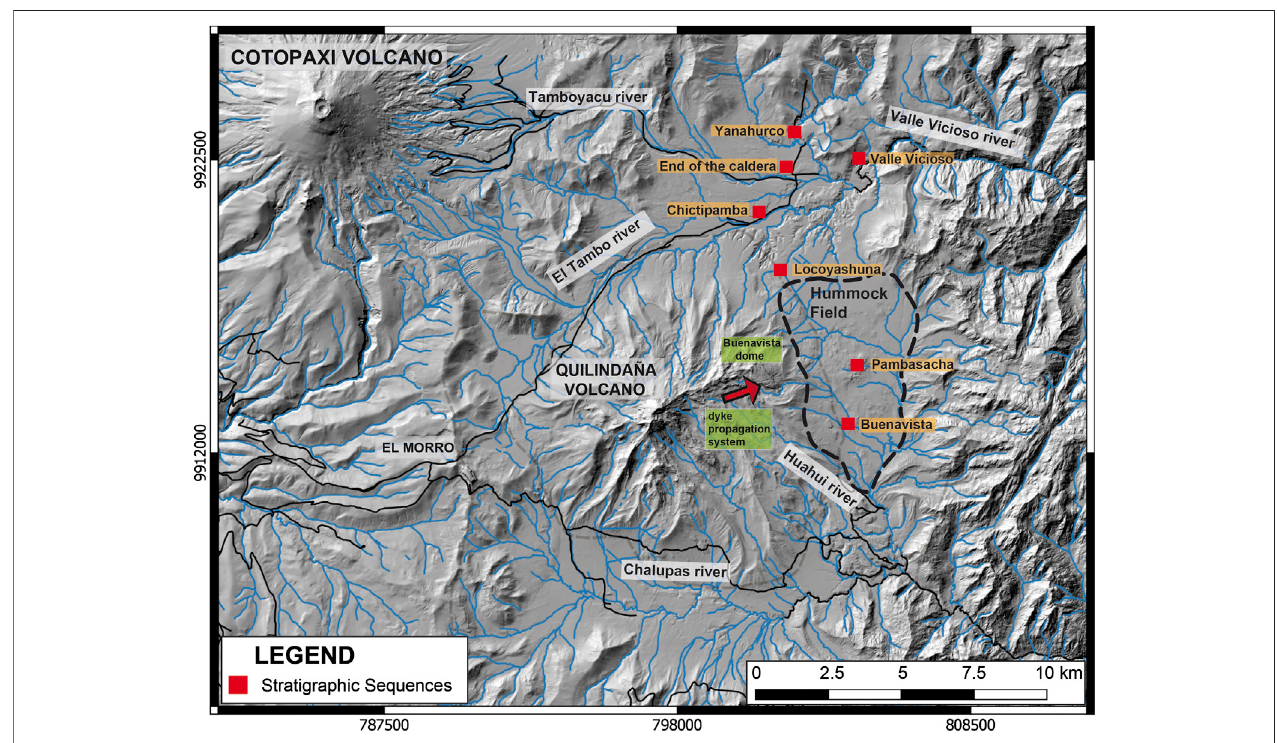
FIGURE 8 | Map showing hummock topography related to the Buenavista Dome fan on the eastern Chalupas plain, in the vicinity of Pambasacha and Buenavista stream cut sequences, and location of stratigraphic sequences discussed in the text. Mapped hummock fi eld perimeter is delimited by broken black line and occupies the eastern Chalupas plain, which is con fi ned between the Buenavista dome massif and steep - relief topography to the east.